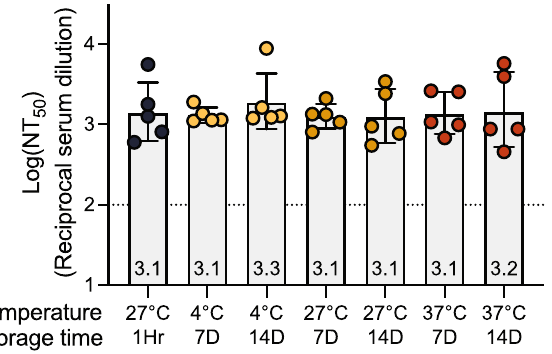
Fig. 2 | Formulated DCFHP-alum is thermostable up to 37°C for 14 days. Neu- tralizationtitersagainstWuhan-1SARS-CoV-2pseudovirusforserumobtainedfrom individualanimals21daysfollowingimmunizationwithDCFHP-alum(10 µ gDCFHP with 150 µ g alum) that had been stored at a range of temperatures (bottom) for either 7 days or 14 days, compared to freshly formulated DCFHP-alum (left, black circles). Assay limits of quantitation is shown as a dotted horizontal line. A single representativeexperimentofsamplesrunintechnicalduplicateisshown.GMTand STD are